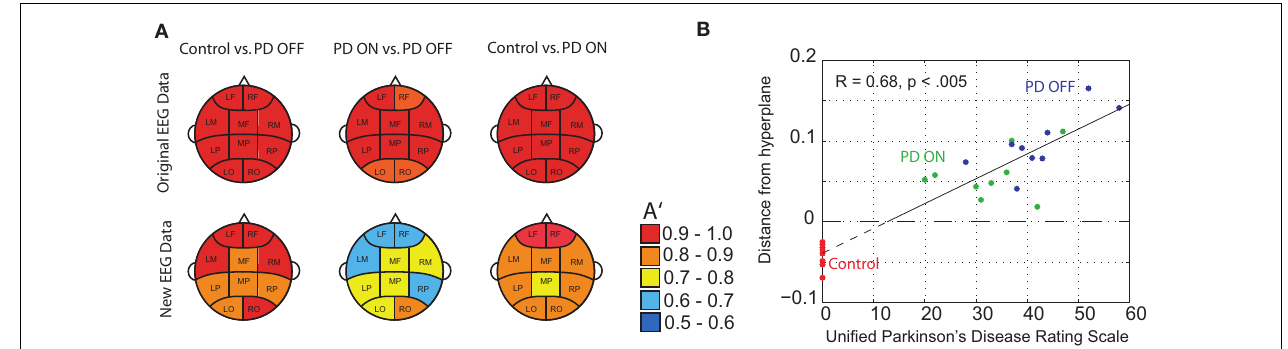
FIGURE 4 | (A) Classification performance of three different classifications using A (cid:48) (area under the receiver-operating characteristic curve) on the mean of the original 50 randomly selected 1-s trials of baseline EEG used for training and the mean of 50 new 1-s trials from the same subjects, and